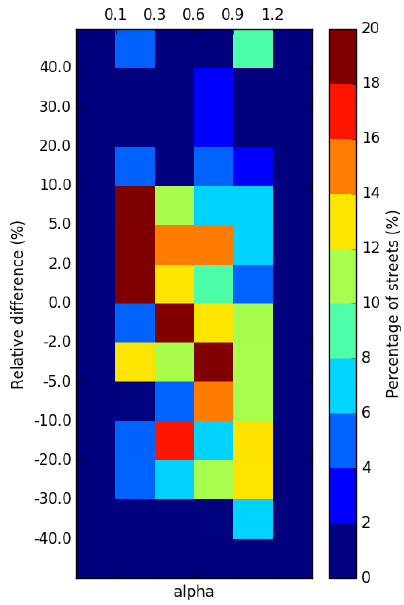
Figure 7. Percentage of streets (purple) present in different α r in- tervals for different ranges of the relative differences between the BC concentrations simulated by SinG and